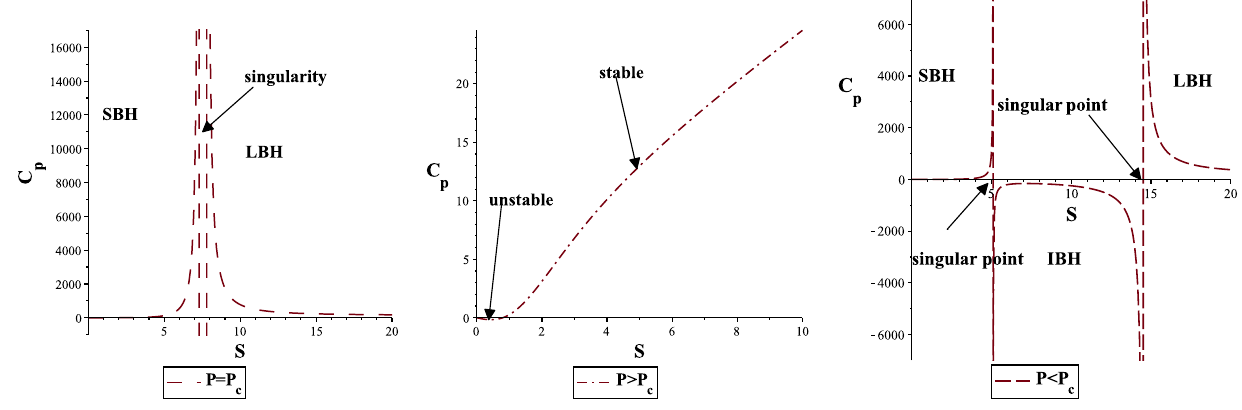
Fig. 9 C p versus S with a 2 = 1, e = 0 . 2 and g = 0 . 6. Left panel: P = P c , middle panel: P > P c and right panel: P < P c